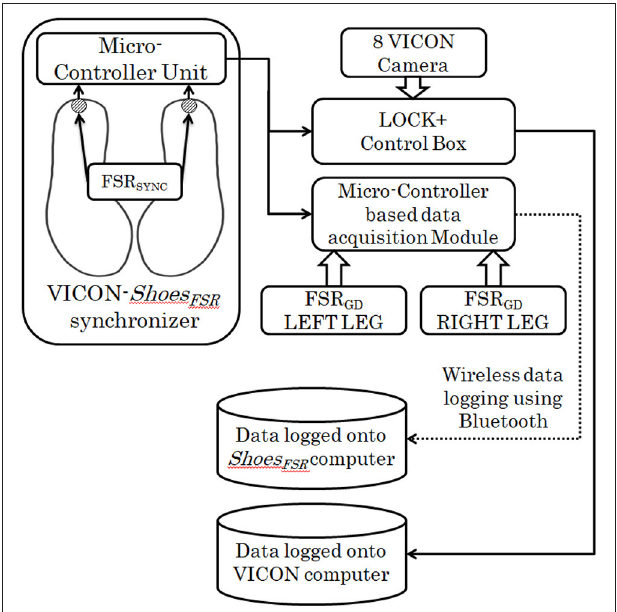
FIGURE 2 | Block Schematic of VICON- Shoes FSR synchronizer.